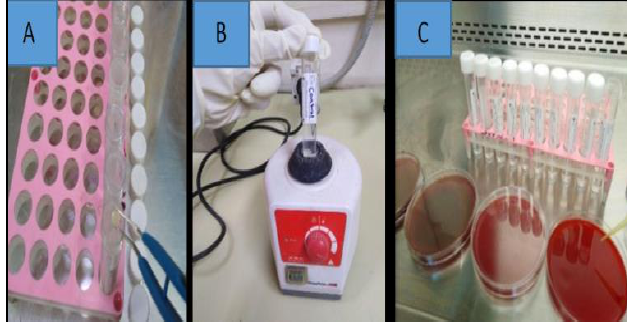
Figure 5: A. Placement of specimen in the normal saline; B. Shacked by auto Vortex for 2 min; C.